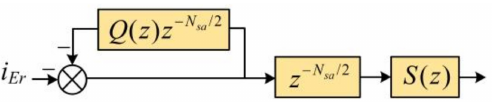
Figure 8. Block diagram of OMRC.